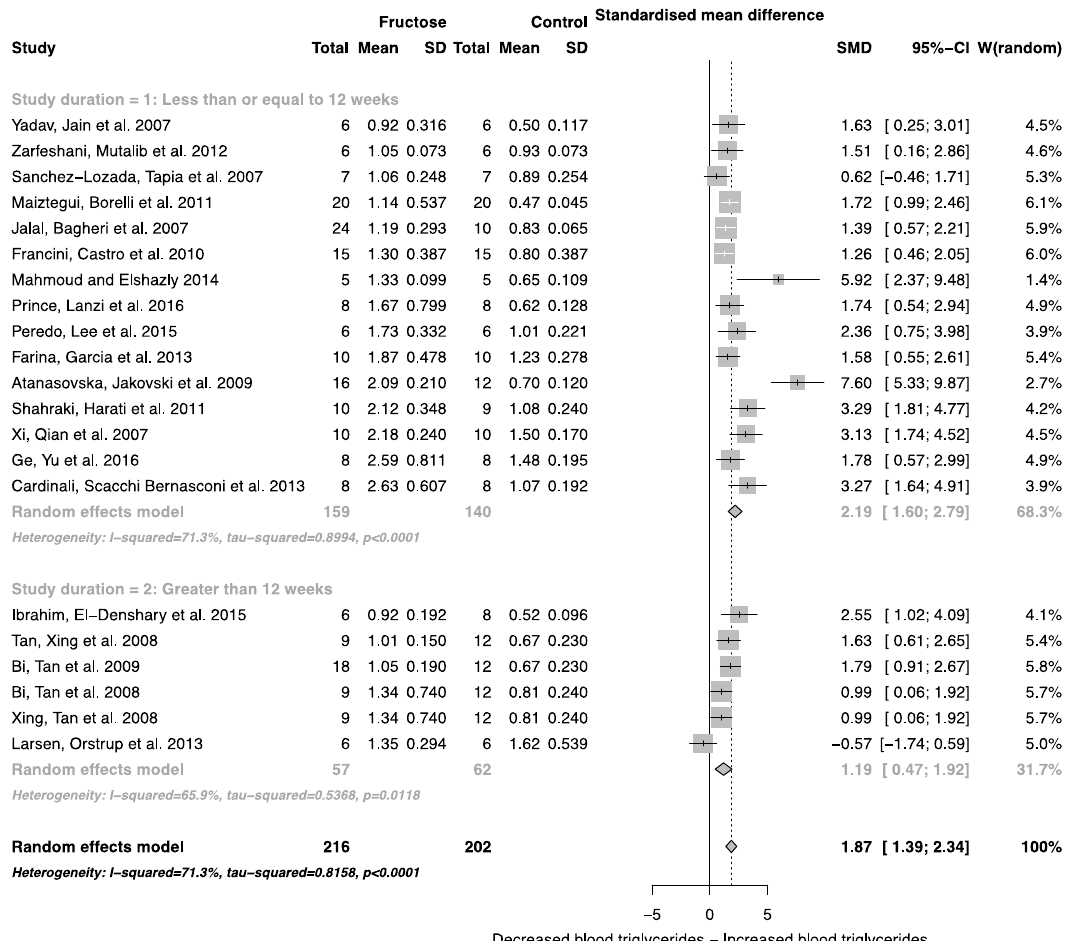
Figure 6. Forest plots of the effect of fructose consumption on adult male rodent blood triglyceride concentration (mean and standard deviation (SD)), split for study duration. The pooled effects estimates are represented by three diamonds; one for studies of 12 weeks or less, one for studies of greater than 12 weeks, and one representing the combined effect. Data are presented as standardized mean differences (SMD) with 95% confidence interval (CI). p -Values are for the inverse variance random effects models with DerSimonian-Laird estimator for Tau 2 . Inter-study heterogeneity was tested by Cochran’s Q at a significance of p < 0.10 and quantified by I 2 .